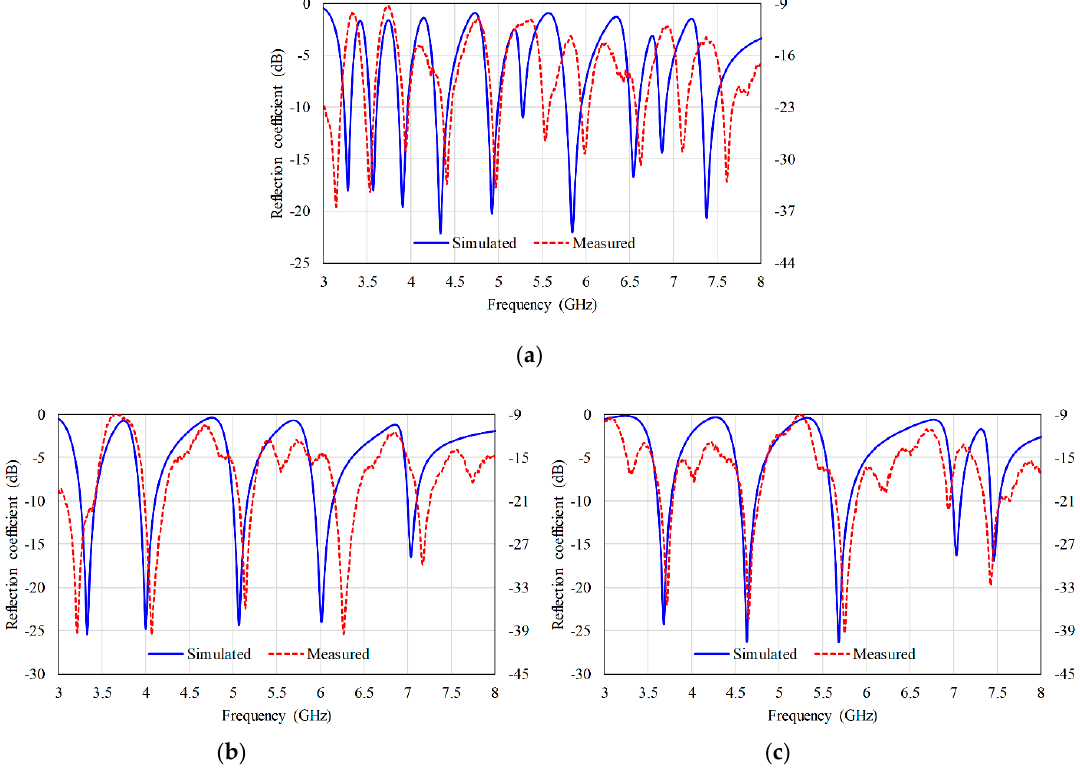
Figure 15. Simulated and measured S 11 under horizontal polarization for 10 cm distance from the RFID reader: ( a ) ID: 11111111111111111111, ( b ) ID: 11001100110011001100, and ( c ) ID: 00110011001100110011.